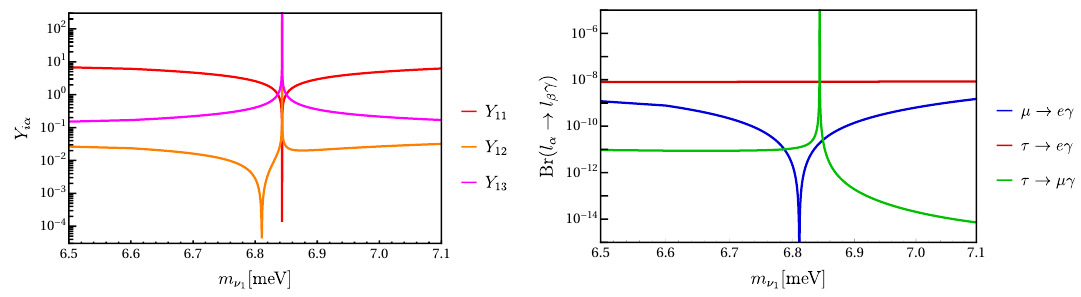
Figure 12 . To the left, the entries of the (cid:12)rst row of the Yukawa coupling matrix Y zoomed around the poles for Y 11 and Y 12 for (cid:11) 12 = (cid:11) 13 = (cid:14) = (cid:25) . To the right, the calculated Br( l (cid:11) l (cid:12) (cid:13) ). ! Both computed (cid:12)xing for Y 21 = Y 31 = 0 and at the minimum allowed value of m N =F AKS . R While a pole for Y 11 exists, no pole for Br( (cid:22) e(cid:13) ) or Br( (cid:28) e(cid:13) ) is associated to it, due to the ! ! divergence of Y 12 and Y 13 on the pole. Note that only near the pole for Y 12 Br( (cid:22) e(cid:13) ) is below ! the experimental